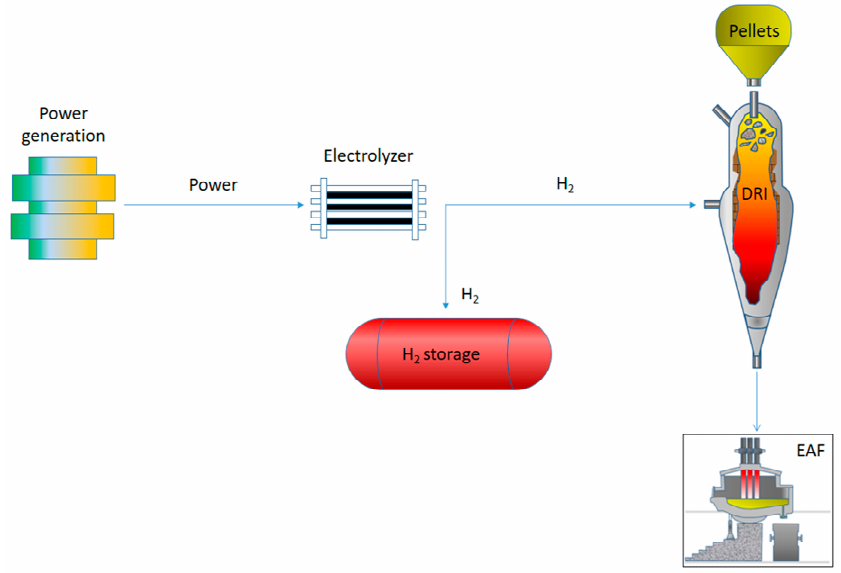
Figure 13. Schematic of integrated fossil-free primary steelmaking.